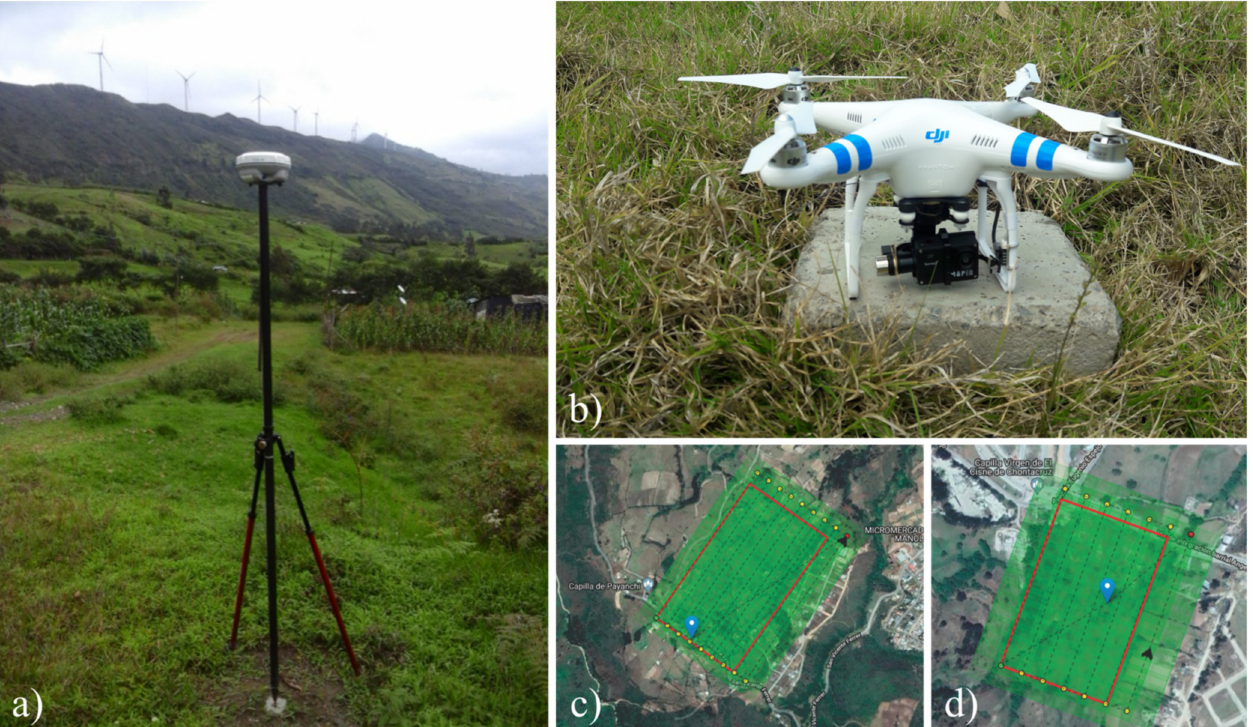
Figure 4. ( a ) Trimble GNSS receiver model R6 used for the measurements on the control network; ( b ) Phantom 2 drone equipped with a ventral camera; ( c , d ) flight path planning in the Victoria and Colinas Lojanas study areas,